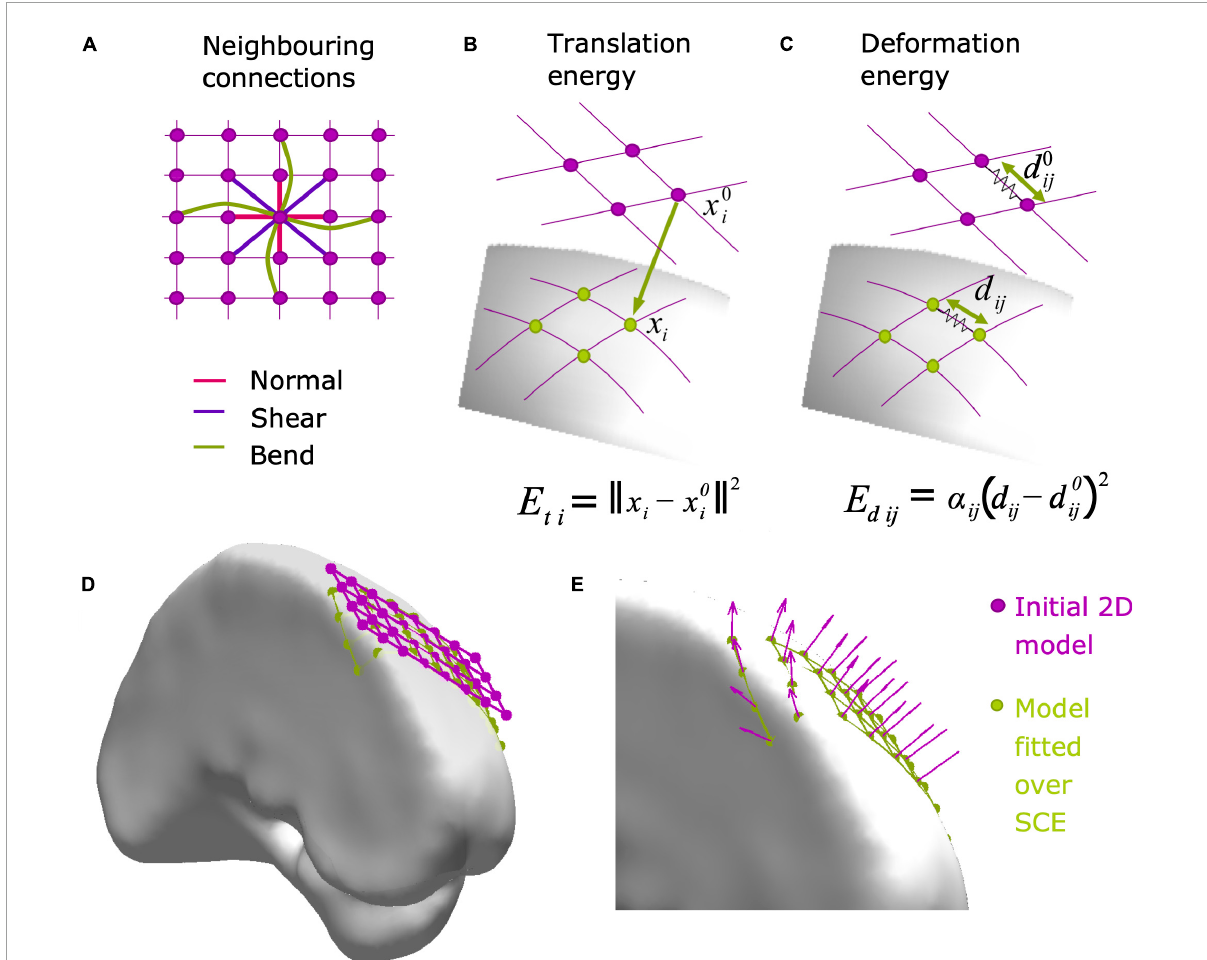
FIGURE2 Modeling grid and strip electrode coordinates over the SCE surface. Electrode arrays are initially modeled as 2D (grids) or 1D (strips) objects, and then fitted to the SCE surface by minimizing the translation ( E t ) and deformation ( E d ) energies (Equation 1). (A) First, diagonal, and second neighboring connections are used to compute the deformation energy E d , accounting for normal, shear, and bending, respectively. (B) The translation energy E ti associated with electrode i is proportional to the distance between the initial ( x 0 i ) and the final location ( x i ) over the SCE surface. (C) The deformation energy E dij associated with neighboring electrodes i and j is proportional to the amount of deformation between the original ( d 0 ij ) and final distance ( d ij ). Equation details are explained in Subsection “Modeling grid and strip electrode coordinates”. (D) Example of a 2D grid model (4 × 8, 10 mm IED) before (pink) and after (green) being fitted to the SCE surface on the left frontal lobe. (E) Zoom-in detail showing the normal vectors at each electrode location. Normal vectors are subsequently used to orient the simulated CT artifacts. IED, inter-electrode distance; SCE, smooth cortical